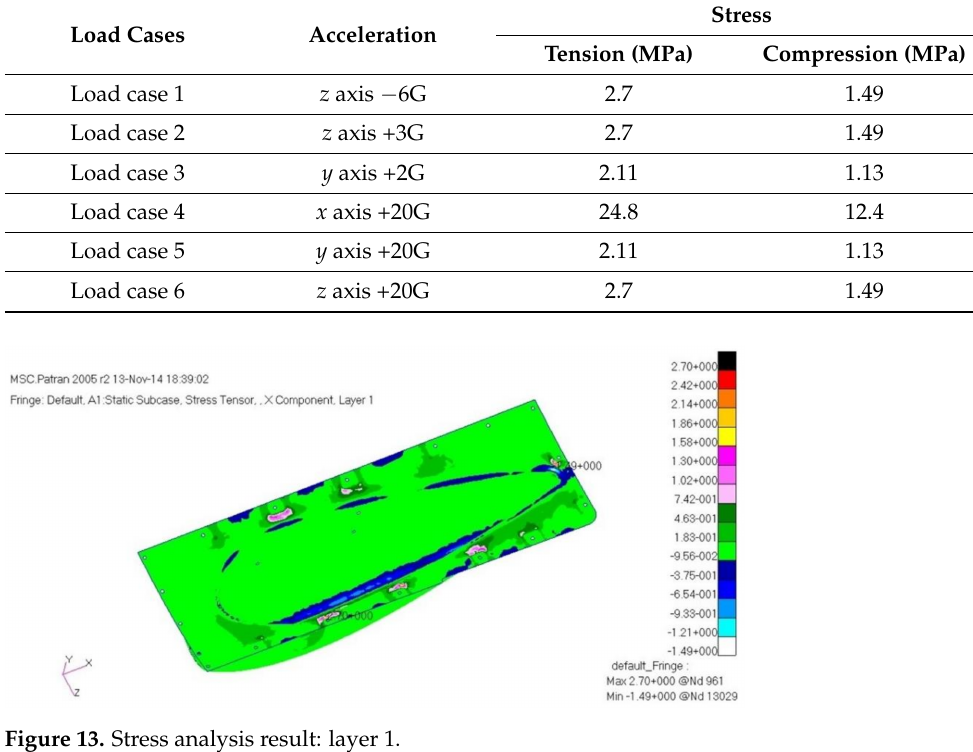
Figure 13. Stress analysis result: layer 1.